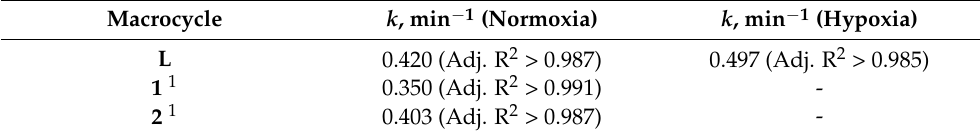
Table 2. Reduction kinetics of the macrocycles L , 1, and 2 in the presence of SDT; 1 [34]. Macrocycle